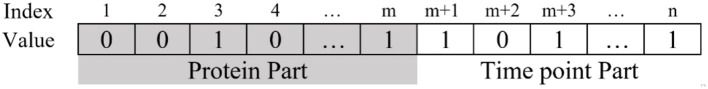
The structure of each chromosome of memetic algorithm.